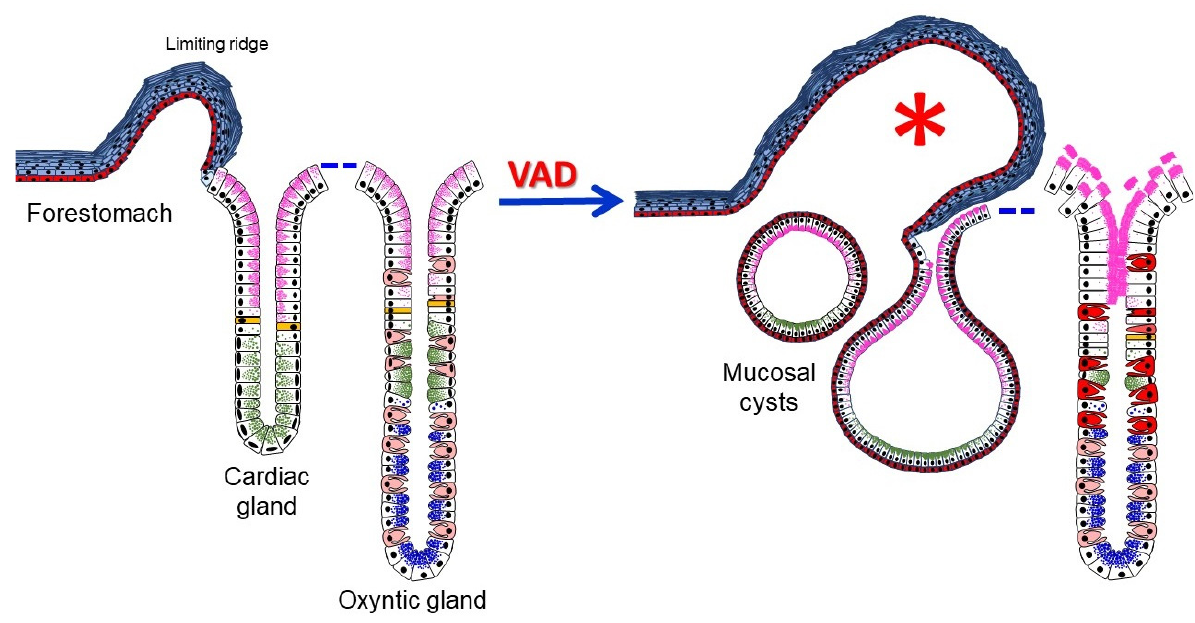
Figure 11. Schematic diagram of control and VAD squamocolumnar junctional epithelium. In the control stomach, the stratified squamous epithelium forms a small limiting ridge that merges with the glandular epithelium of the cardia. The cardiac gland includes a few stem cells (yellow) that give rise to two mucous cell lineages (pink and green granules). The control oxyntic gland also includes dividing stem cells (yellow) that give rise not only to mucous cell lineages (with pink and green granules), but also to parietal cells (nongranular pink cytoplasm). Mucous neck cells contribute mostly to form zymogenic cells (with blue granules) at the bottom. The 8-month VAD tissue develops protrusion with overgrowth of limiting ridge (asterisk), mucosal cysts lined by 2 layers of cells and express P63 at the transition zone, loss of integrity of surface epithelium, reduction in cell proliferation, and increased H + ,K + -ATPase expression in the scattered parietal cells (dark red).